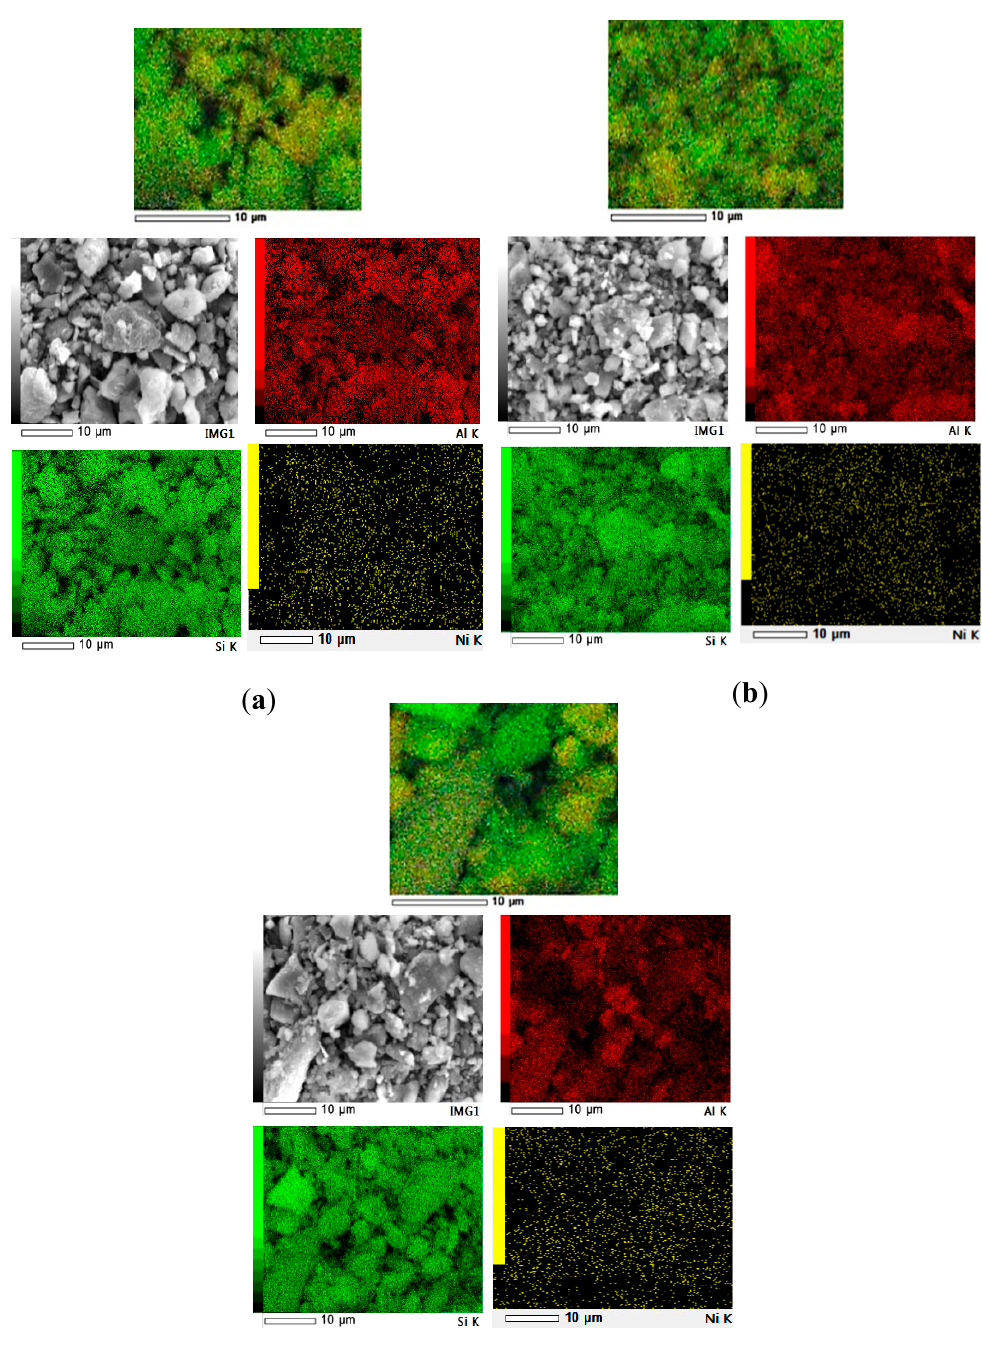
Figure 4. SEM mapping of ( a ) Ni-Z3, ( b ) Ni-Z5, and ( c ) Ni-Z7 catalysts.